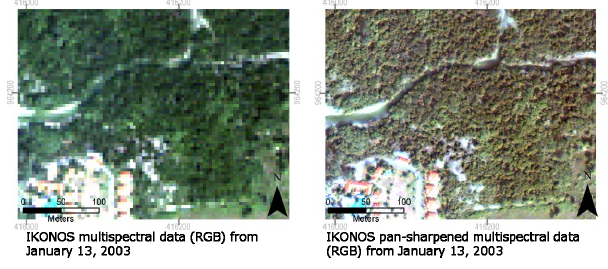
Fig. 3. IKONOS pan-sharpening based on the Gram-Schmidt-spectral sharpening technique (northern Khao Lak)